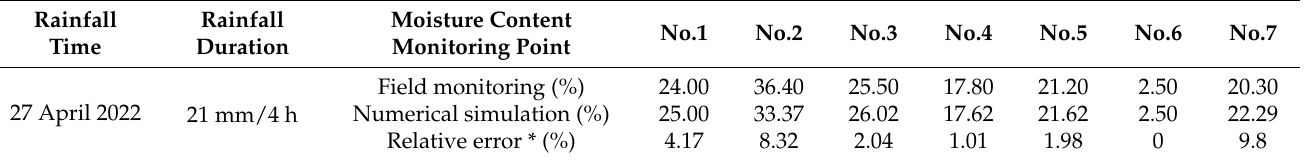
Table 2. Comparison of water content results.